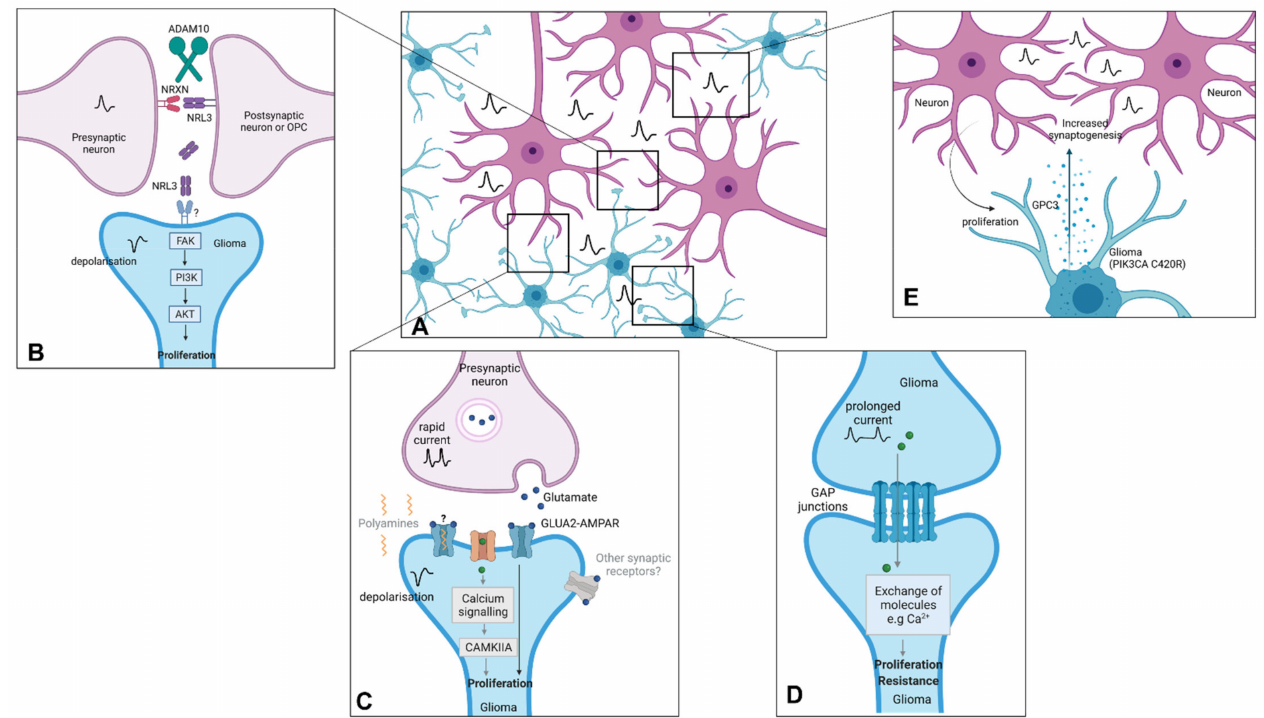
Figure 4. Schematic representation of established and potential interactions between the DMG and neuronal microen- vironments. ( A ) DMGs form a complex network involving direct communication with neurons and glioma cells. ( B ) Typically, synaptic neuron interaction occurs through the NLG3/NRXN axis. Metalloproteinase ADAM10 cleaves